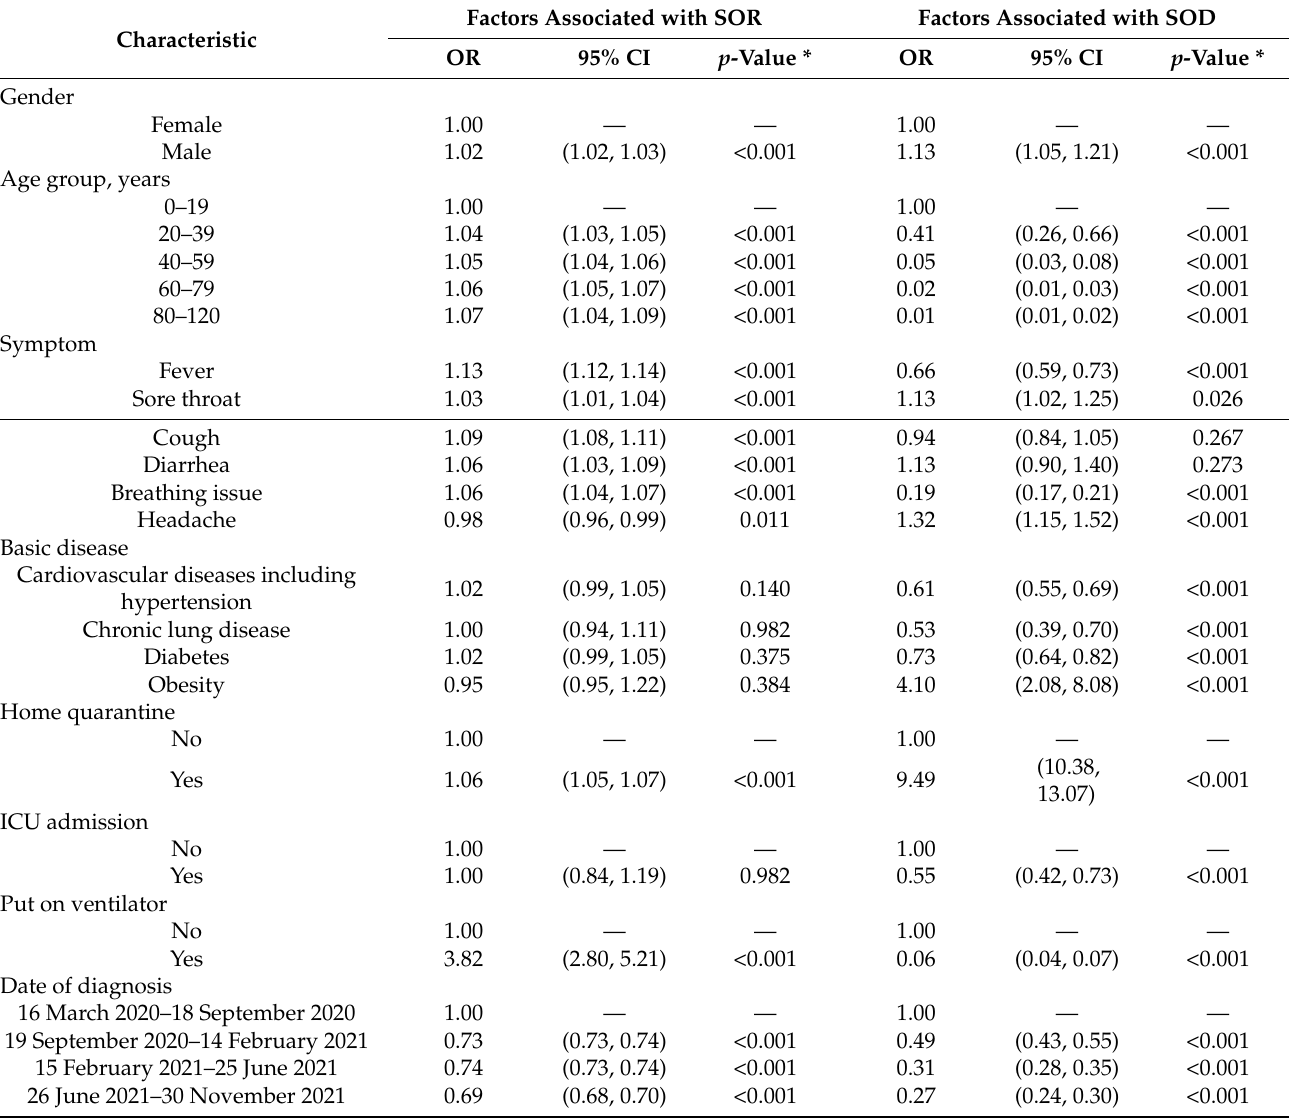
Table 5. Factors associated with the length of SOR and SOD in all confirmed